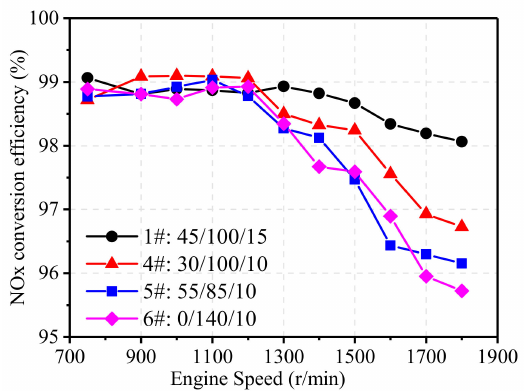
Figure 13. E ff ect of noble metals ratio on NOx conversion e ffi